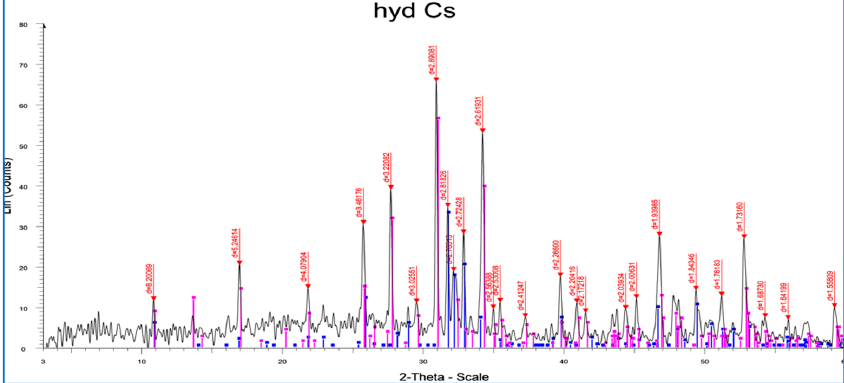
Figure 2. X-ray diffraction (XRD) pattern of Hap/CS nanocomposite. Peaks located at 31.4 ◦ , 32.2 ◦ , and 33 ◦ , representing the nanostructured hydroxy apatite [25]. It was also possible to observe some lower intensity secondary peaks located at 26 ◦ , 40 ◦ , and 47 ◦ , and another less intense peak located at 53.2 ◦ , which corroborate the existence of hydroxyapatite. It was concluded that the Hap/CS nanocomposite is highly